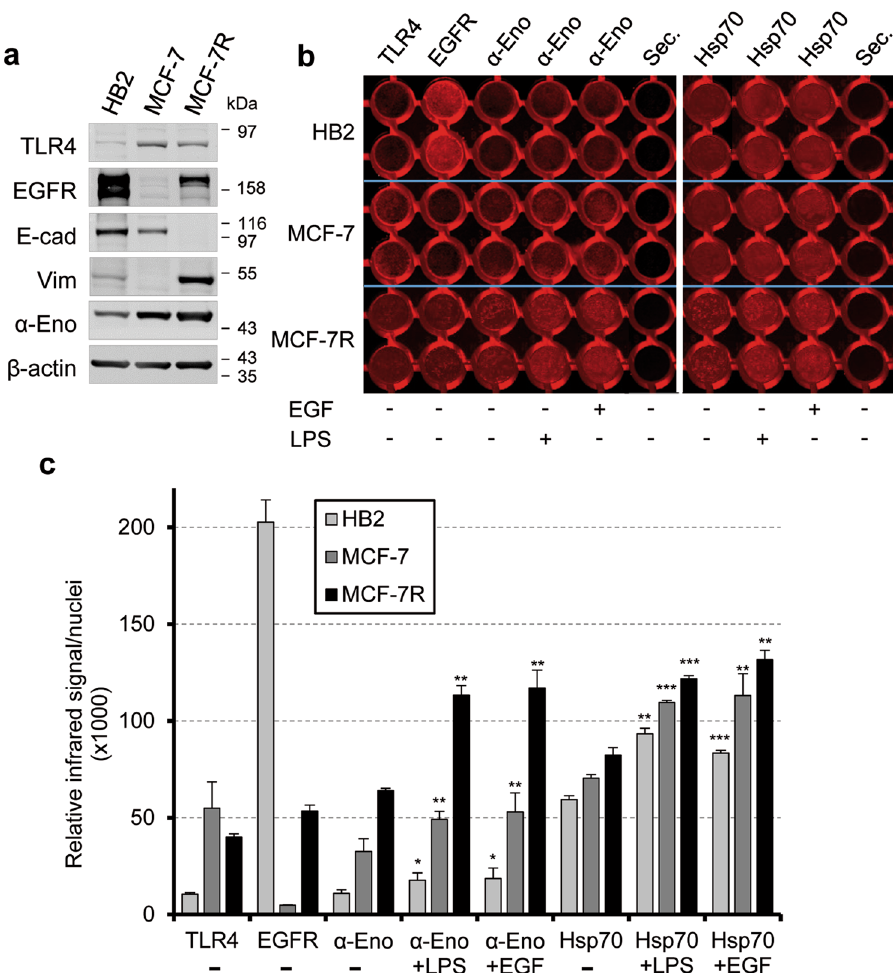
Figure 3. Live on-cell western recapitulates live immunofluorescence staining data. ( a ) Comparative immunoblotting analyses of total proteins from HB2, MCF-7 and MCF-7R cells with antibodies against cell surface receptors, i.e. TLR4 and EGFR, E-cadherin (E-cad), Vimentin (Vim) and alpha-enolase ( α -Eno). β -actin is shown as a control of the total proteins loaded per lane. ( b ) Representative image of the infrared signal emission from a 96-well tissue culture plate processed by live on-cell western with the indicated primary antibodies. The image shows ten duplicate wells/cell type of confluent HB2, MCF-7 and MCF-7R cells in control conditions ( − ) or after treatment ( + ) with 5 µ g/ml LPS or 0.1 µ g/ml EGF, for 24 hours. The omission of primary antibodies (sec.) is shown as a control of specificity. ( c ) The bar graph shows the relative mean infrared intensity for live on-cell western analyses, corrected for nuclei staining. Each data point is the average of three independent experiments, error bars represent standard deviation and p values ( * P < 0.05, ** P < 0.01, *** P < 0.001) indicate statistical significance relative to the untreated